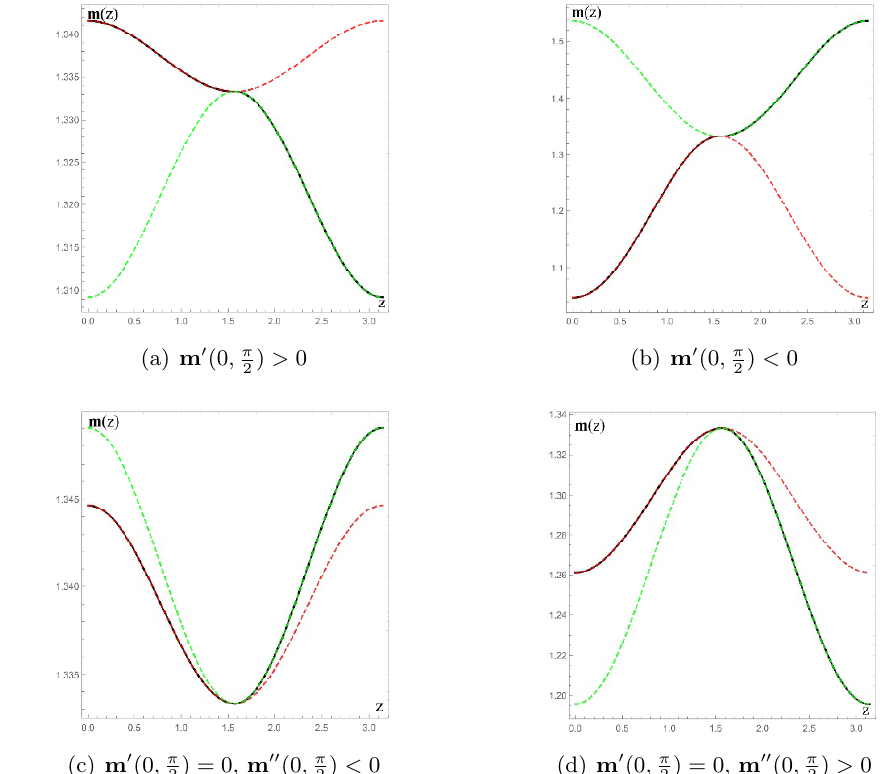
Figure 3 . The possible stable (cid:12)nal states of the RN-dS black hole under the perturbations when (^(cid:3) ; Q ) satisfy P 2 = 2. Here and in the next (cid:12)gure, the horizontal axis is z and the vertical axis is m ( t; z ). Note that the red and green lines are (cid:12)tted with m ( z ) = (1 + Q 2 ) exp ( a cos 2 z ) in which the parameter a can be di(cid:11)erent on the two